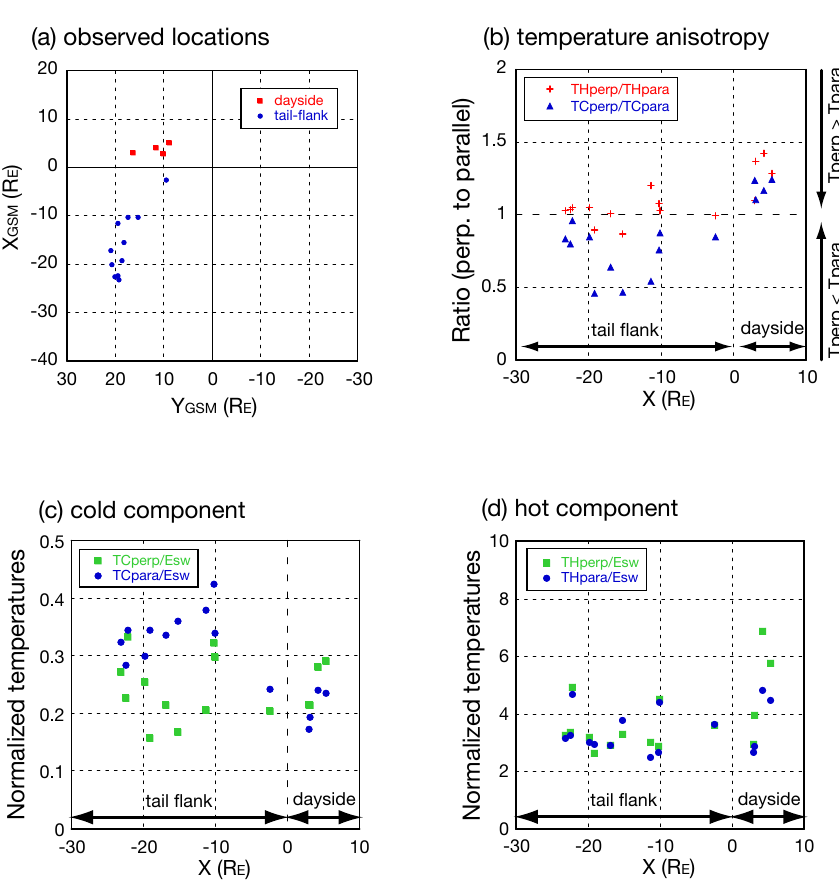
Fig. 6. Statistical plots for the 4 dayside and 11 tail events. Panel (a) shows the projection onto the GSM XY plane of observed locations of the plasma sheet with the two-component protons near the dusk low-latitude boundary. Dayside (tail) events are plotted as red squares (blue circles). Panels (b–d) show relation between the X coordinate of the observed locations and the temperature parameters. Panel (b) shows anisotropy of each component (ratio of perpendicular to parallel temperature). The blue (red) point corresponds to the ratio of the cold (hot) component temperatures. Panels (c) and (d) show normalized temperatures of the cold and hot components parallel to and perpendicular to the magnetic field, with blue circles (green squares) corresponding to the parallel (perpendicular) temperature. The temperatures are normalized by the kinetic energy of the solar wind protons